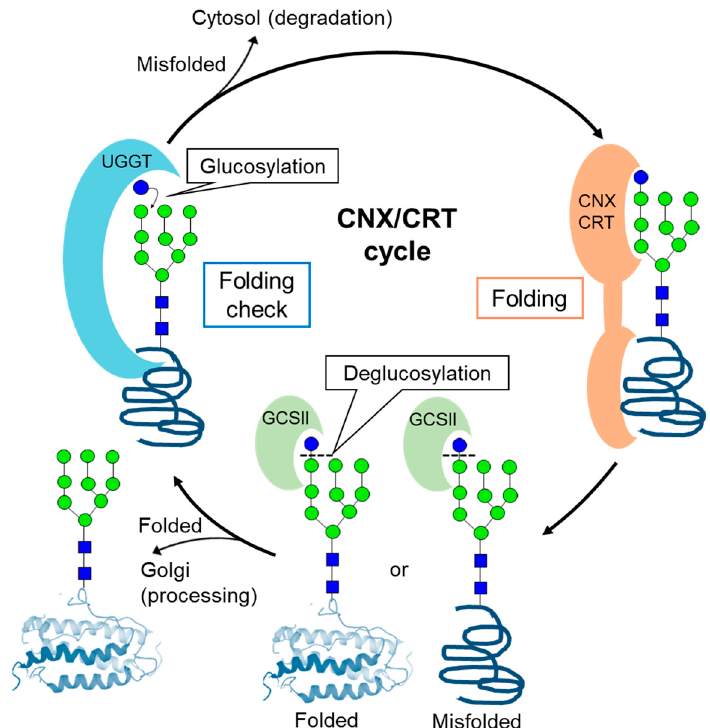
Figure 7. Protein quality control utilizing high-mannose-type N -glycan as a tag. UDP-glucose:glycoprotein glucosyltransferase (UGGT) complex distinguishes misfolded glycoproteins to transfer glucose to the nonreducing end of the high-mannose glycan. This monoglycosylation serves as a marker for misfolded glycoproteins and the chaperone proteins calnexin/calreticulin (CNT/CRT) promotes folding.